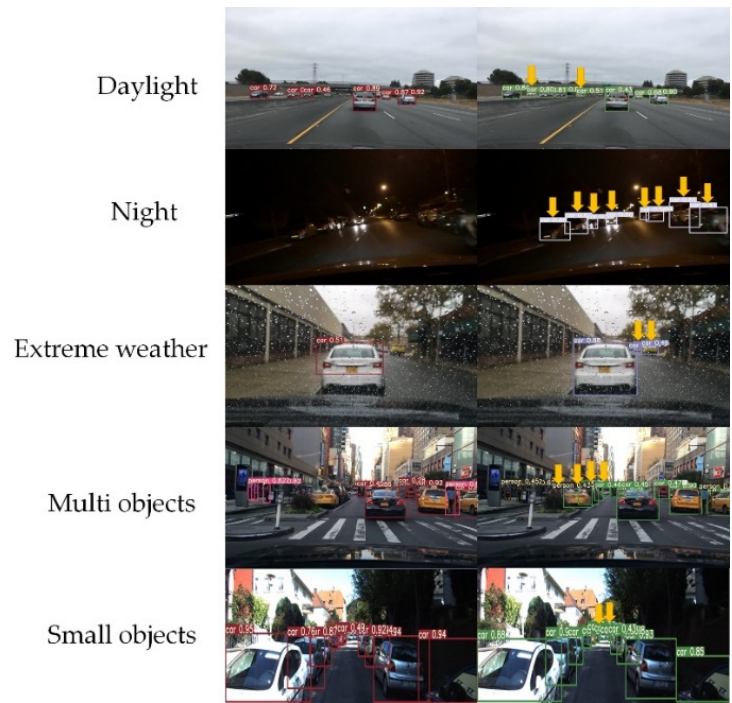
Figure 11. Example Figure 11. Example comparison.